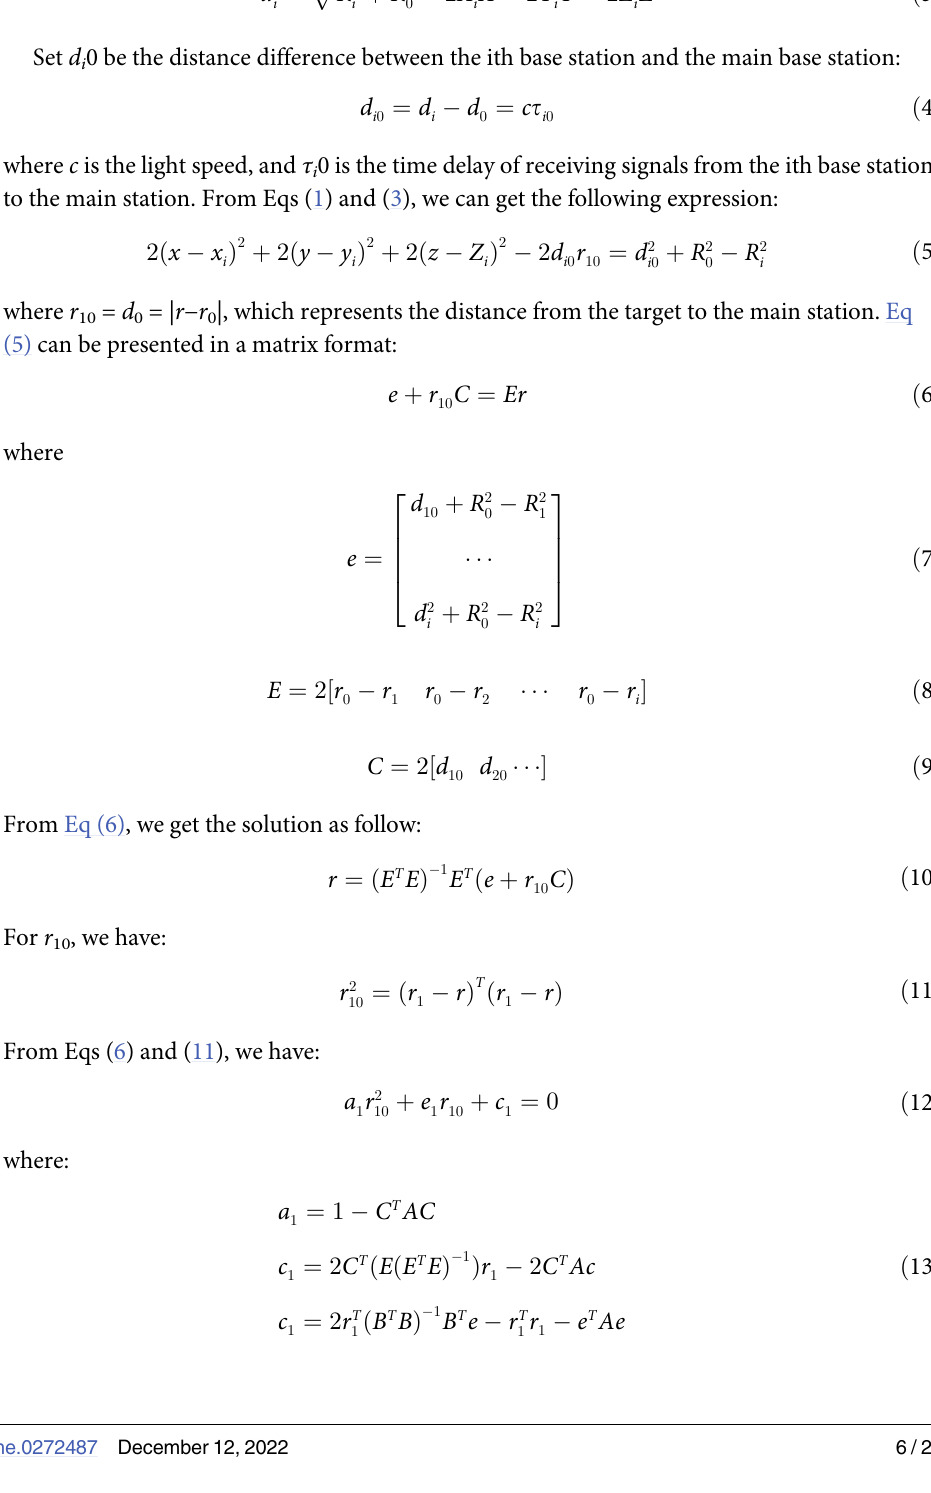
þ Z 2 0 þ Z 2 i